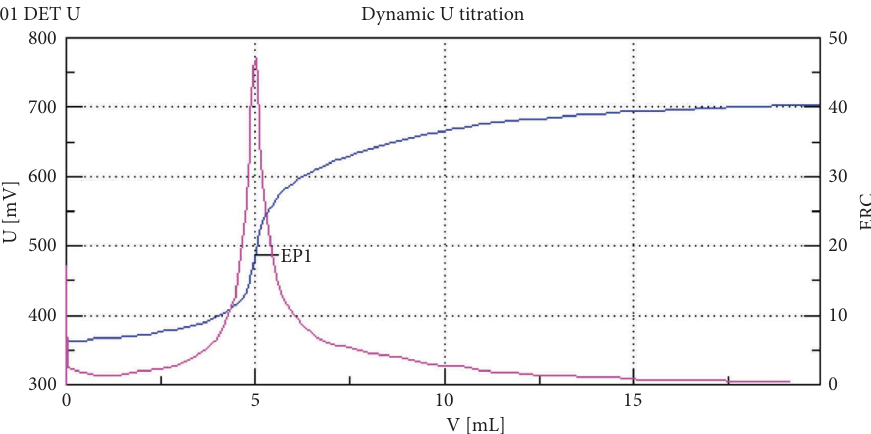
Figure 3: Te chromatogram of the potentiometric titration for assaying the TFC content in the crude sample in perchloric acid.